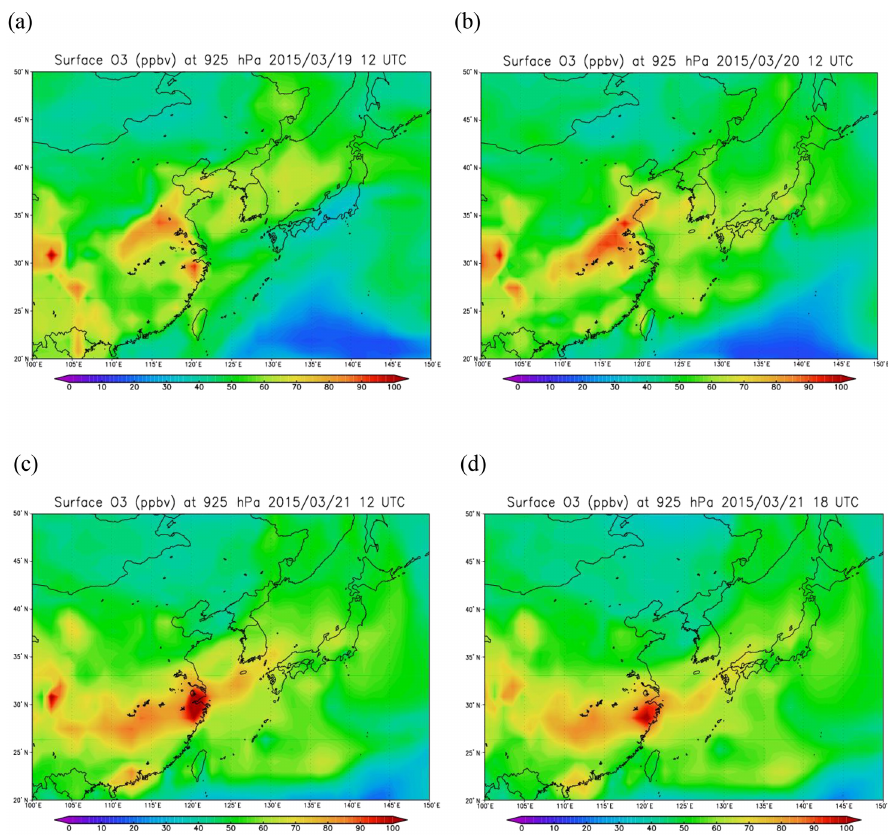
Figure 10. Horizontal maps of ozone volume mixing ratios inppbv predicted by MRI-CCM2 for the 925hPa pressure level (an altitude of about 760m) at 21:00JST (JST = UT + 9) on (a) 19, (b) 20 and (c) 21 March and (d) at 03:00JST on 22 March 2015.